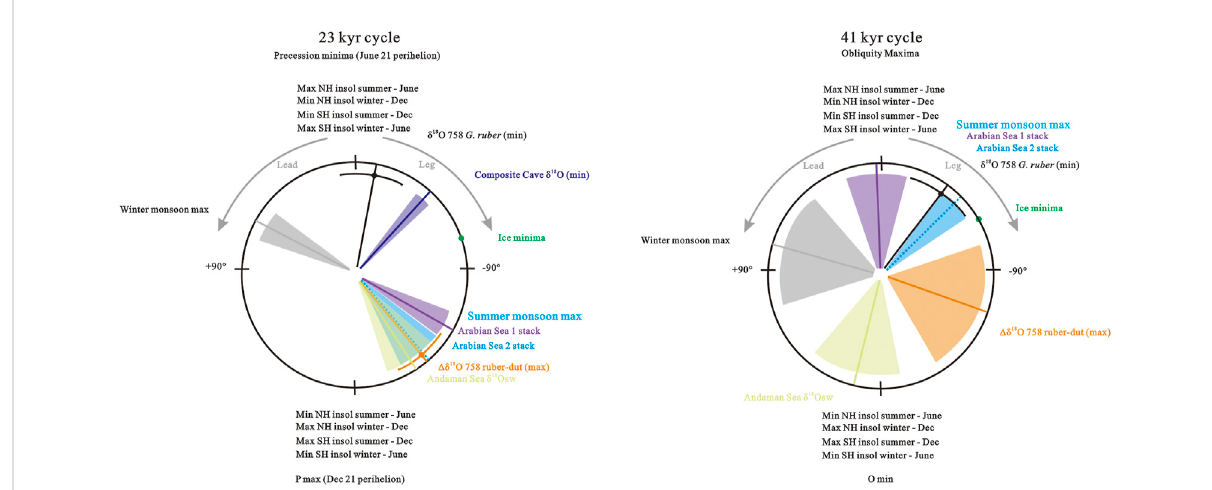
FIGURE 5 Phase wheels illustrating ISM response to orbital forcing. The precession index is de fi ned as Δ ε sin ω , where ω is the longitude of the perihelion measuredfromthemovingvernalpointand ε istheeccentricityofEarth ’ sorbitaboutthesun(Laskaretal.,1993;BergerandLoutre,1997).Obliquityis the axial tilt of Earth ’ s rotation axis with respect to the orbital plane. In the phase wheel representation, the 12 o ’ clock position is set to precession minima ( p min; ω = 90 ° , 21st June perihelion) obliquity maxima ( O max), respectively. Negative/positive phases are measured in the clockwise/ anticlockwisedirectionand represent phase lags/leadsrelative to p min or O max. Published recordsplotted(withshaded phase estimate errors) are the Arabian Sea summer monsoon stacks 1 (Clemens and Prell, 2003) and 2 (Caley et al., 2011c), composite cave δ 18 O records from China (Cheng et al., 2009; Cai et al., 2015), corrected δ 18 O sw records from the Andaman Sea (Gebregiorgis et al., 2018), Δδ 18 O records form Site 758 (Bolton et al., 2013), and winter and summer monsoon maxima (Clemens et al.,